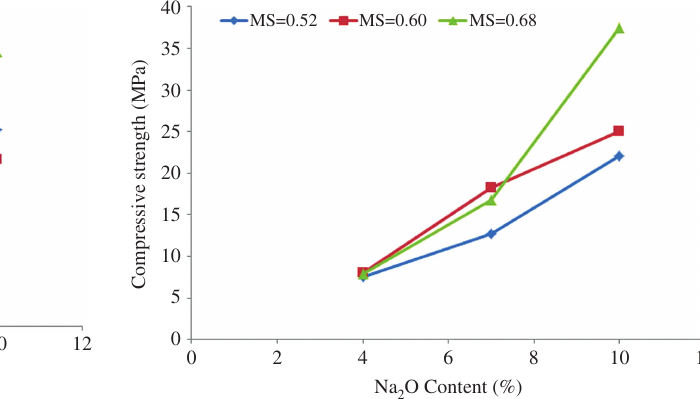
O on 28-day compressive strength for Figure 4 The effect of Na 2 samples cured at 25 ° C and constant MS.